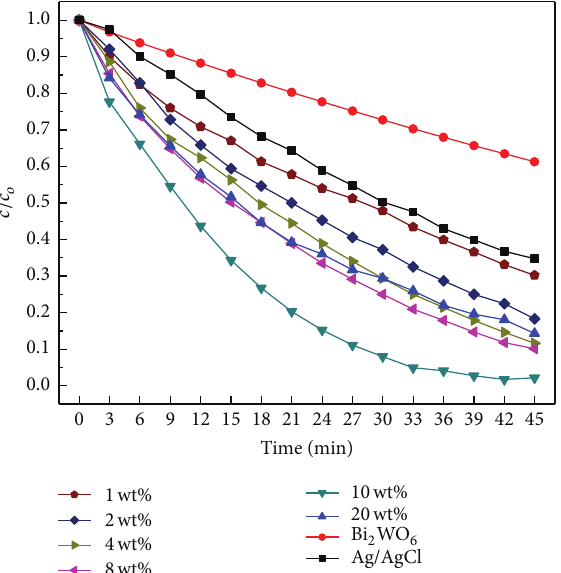
Figure 8: Photocatalytic degradation of RhB (10mg/L) under visible light with as-prepared pure Bi 2 WO 6 , Ag/AgCl, and Ag/AgCl- Bi 2 WO 6